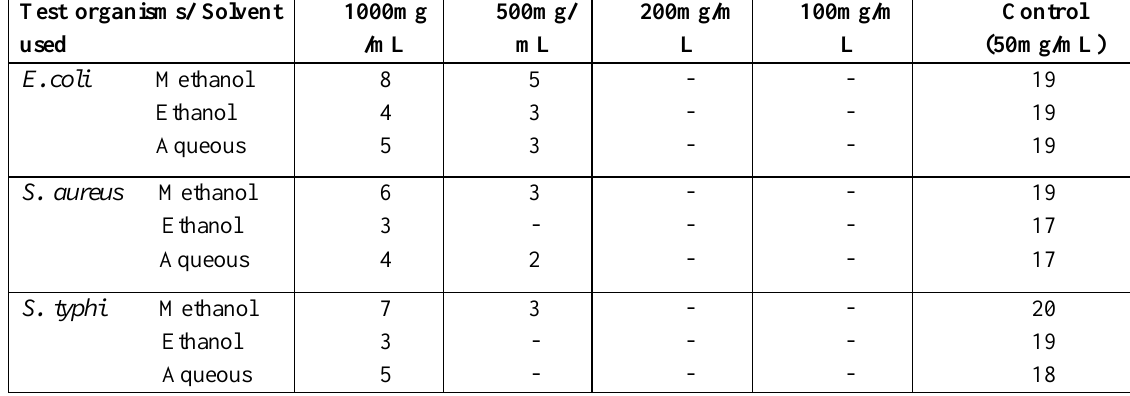
Table 3. Antibacterial activity of methanolic, ethanolic and aqueous stem bark extract on the test organisms in millimeter (mm).